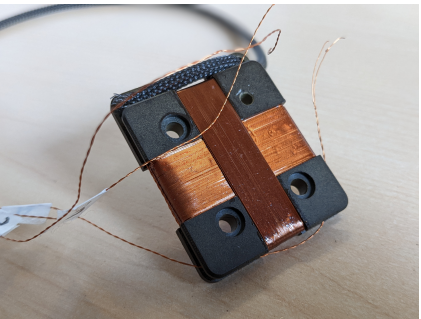
Figure 2. Three axes (3AX) pick-up coil sensor